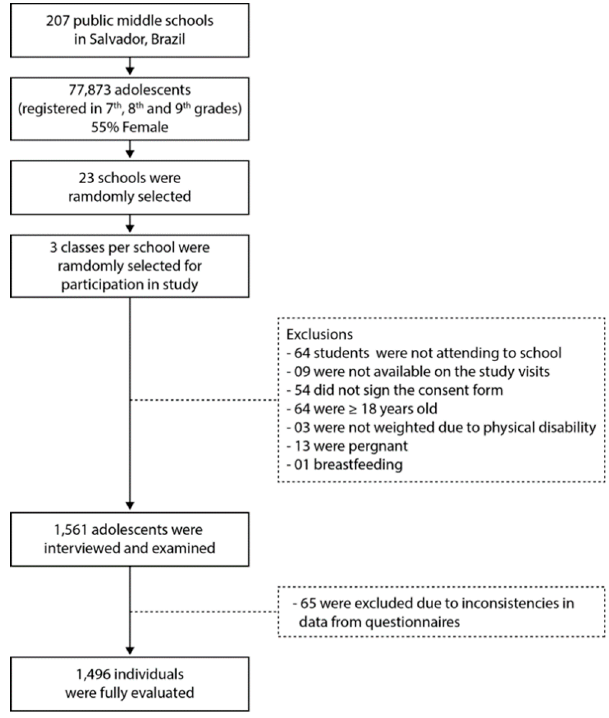
Figure 1. Study flowchart.